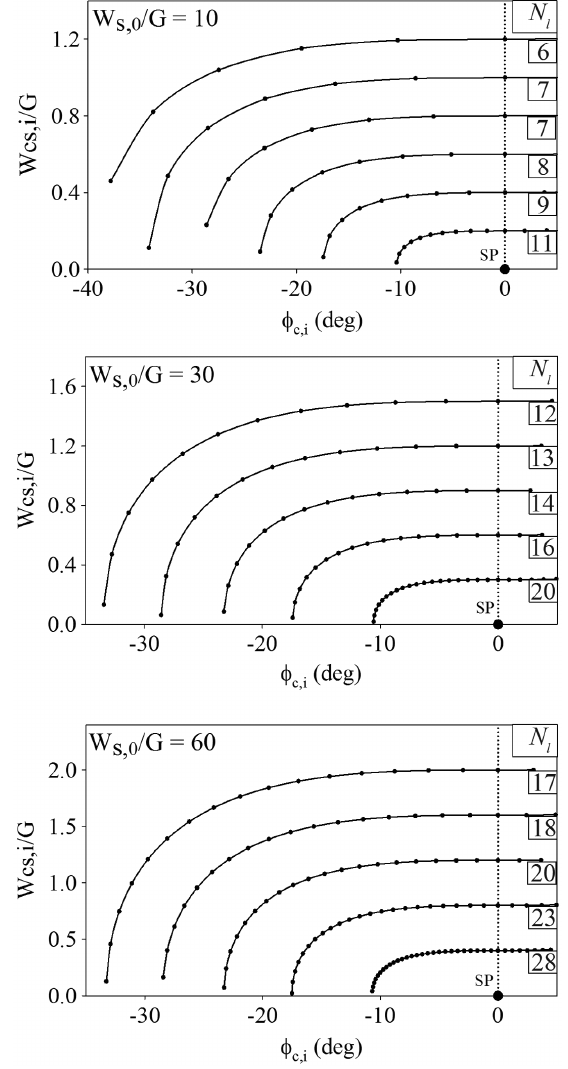
FIG. 10. Traces of the center particle around the synchronous particle for three different ratios of injection energy to gap energy gain G and corresponding gap number values N l in dependence of the surplus in injection energy W cs; 0 . Dots mark gap